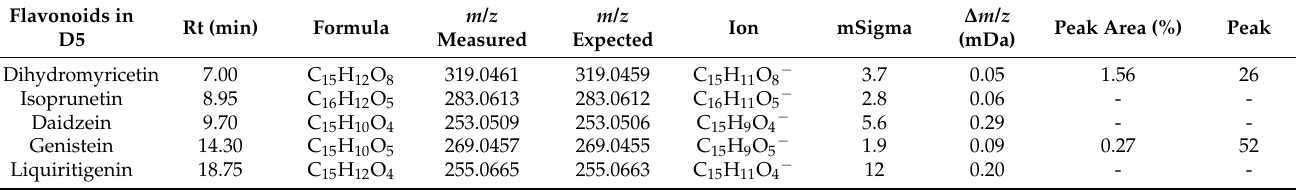
Table 2. Flavonoids identified in the targeted analysis by means of UHPLC-ESI-QToF of the sub-fraction D5 of U. gallii (Rt = retention time, m / z = mass/charge ratio of the compound, mSigma = deviation in the isotopic pattern, ∆ m / z = deviation in the mass ratio/charge measured in relation to the expected value). Flavonoids in